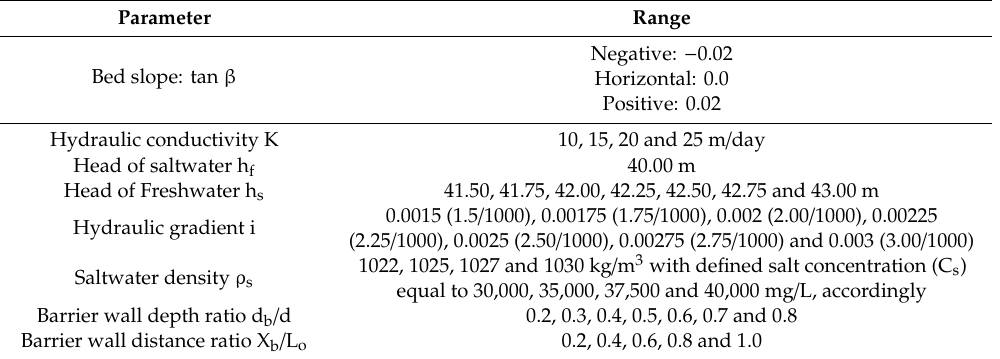
Table 4. Tested numerical simulation range of hydraulic parameters to test the e ff ects on the repulsion ratio